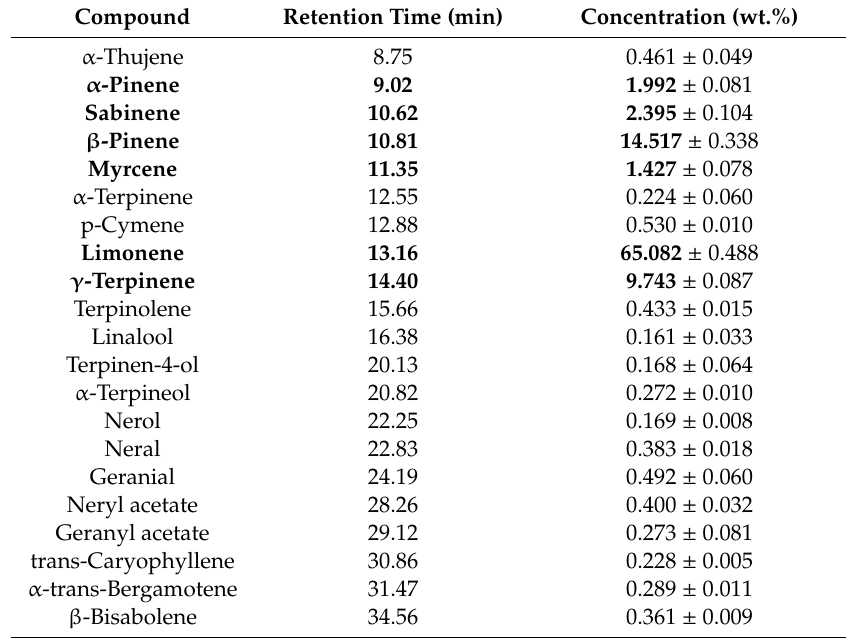
Table 4. Chemical composition of LEO fractions (wt.%) from lemon peels by MAHD. Mean ± SD, n = 3. Compound Retention Time (min) Concentration (wt.%) α -Thujene